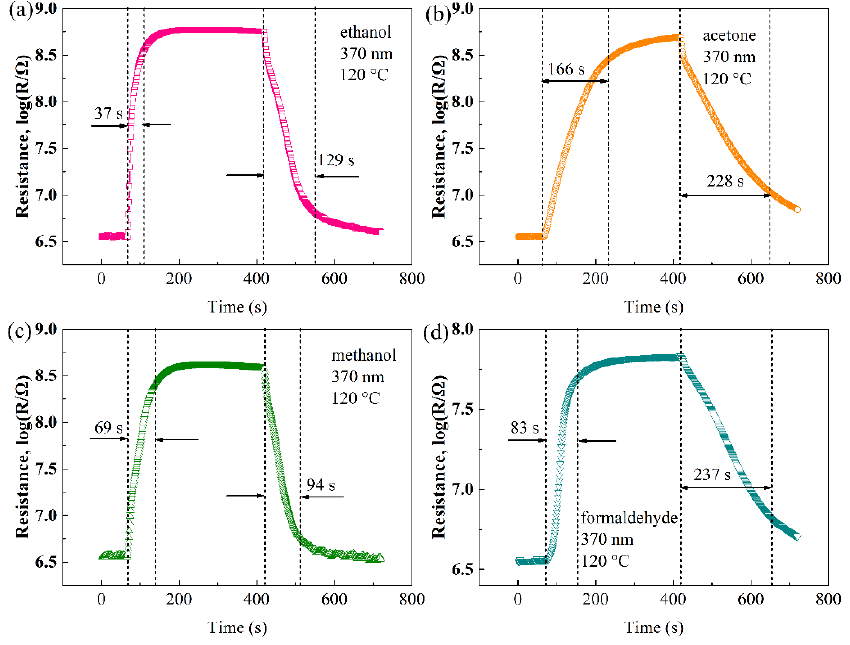
Figure 9. Response/recovery time of the SmFeO 3 /YFeO 3 (0.4:0.6) sensor to VOC gases under 370 nm of light illumination: ( a ) ethanol, ( b ) acetone, ( c ) methanol, and ( d ) formaldehyde.